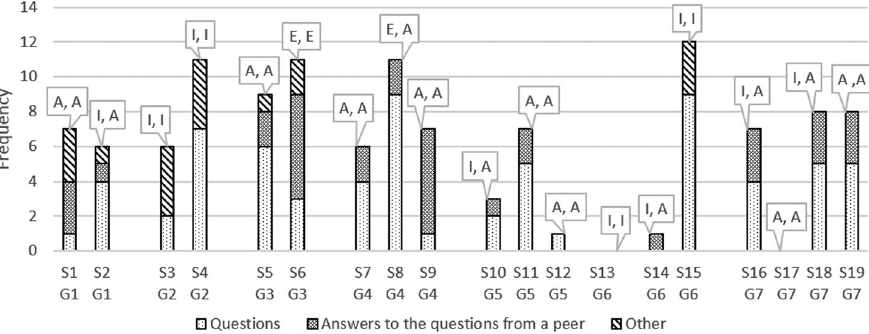
FIG. 5. A substructure of the category “ discussions related to practical issues.